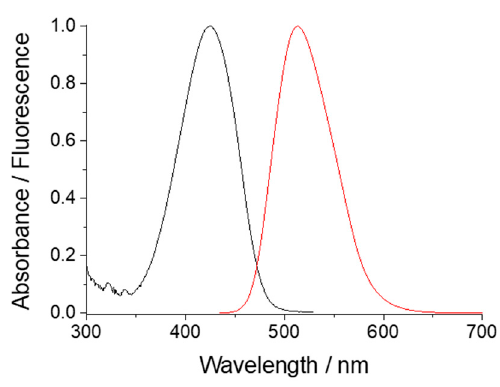
Figure 2. Normalized absorption and fluorescence spectra of NI3 in acetonitrile solution at c = 1 × 10 − 5 mol/L.